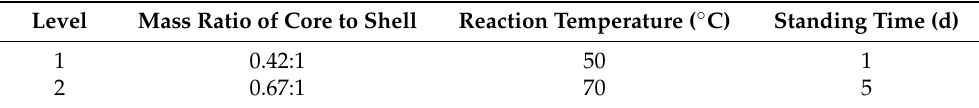
Table 2. Influencing factors and